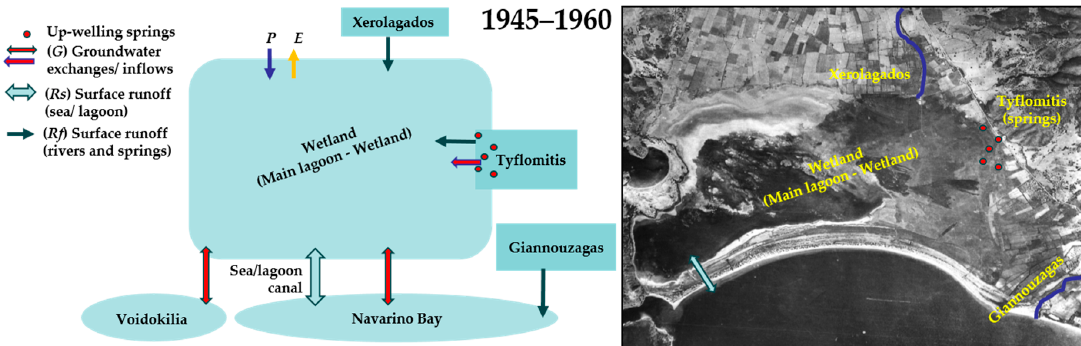
Figure 2. Schematic representation of the hydrologic conditions before the drainage interventions (reference period), based on a 1945 b/w aerial photograph and a map of the same period (Figure S1), complemented with information from KIs and available literature. Potential exchanges via the alluvial deposits and sand barriers are also presented. P and E are abbreviations for precipitation and evaporation, respectively.